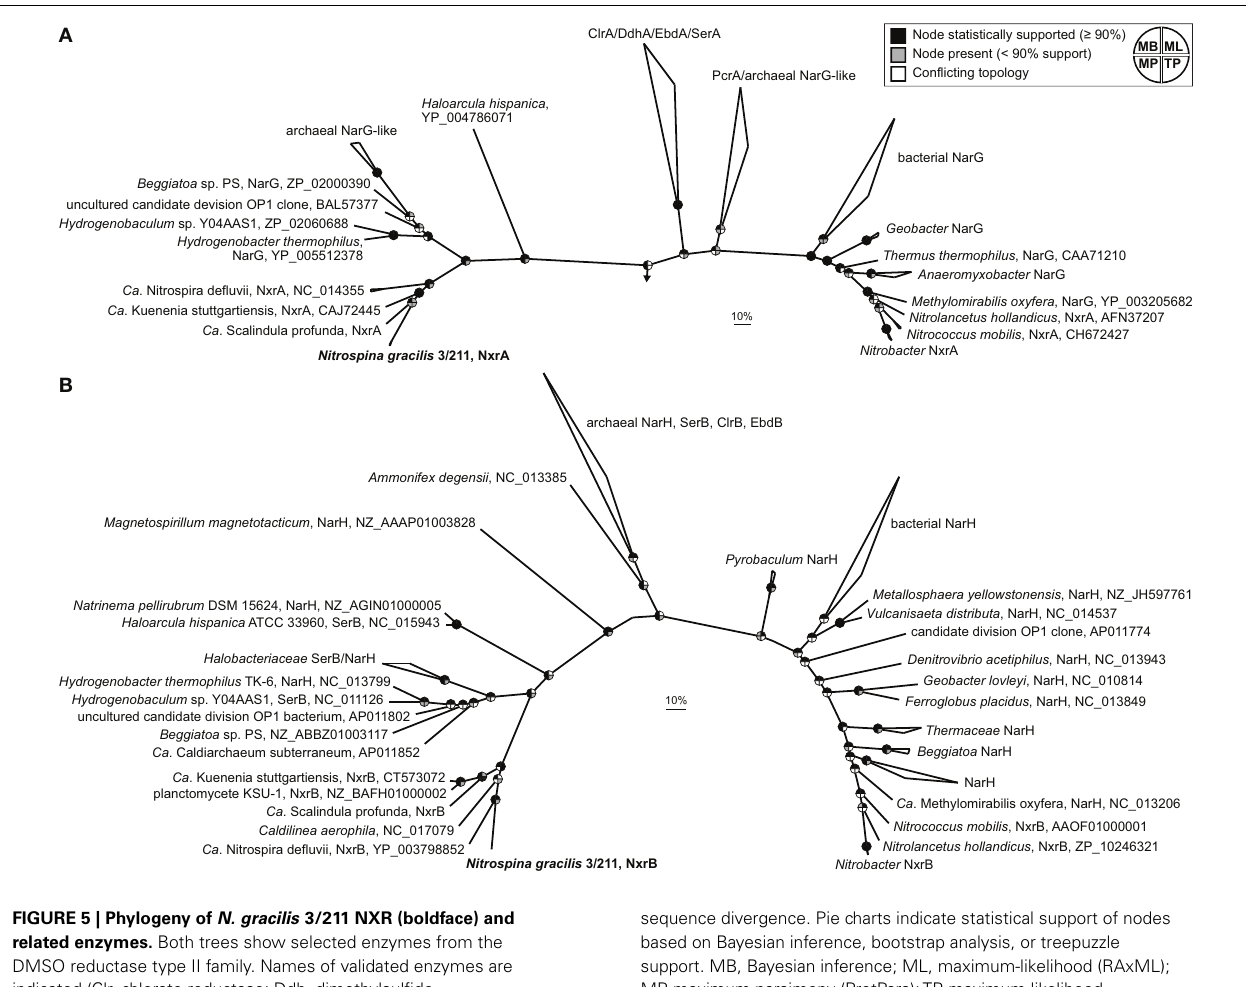
sequence divergence. Pie charts indicate statistical support of nodes based on Bayesian inference, bootstrap analysis, or treepuzzle support. MB, Bayesian inference; ML, maximum-likelihood (RAxML); MP, maximum-parsimony (ProtPars);TP, maximum-likelihood (TreePuzzle). (A) Bayesian interference tree (SD = 0.006924) of the large ( α ) subunit. In total, 1,475 alignment positions were considered. (B) Bayesian interference tree (SD = 0.015471) of the small ( β ) subunit, obtained by using 532 alignment